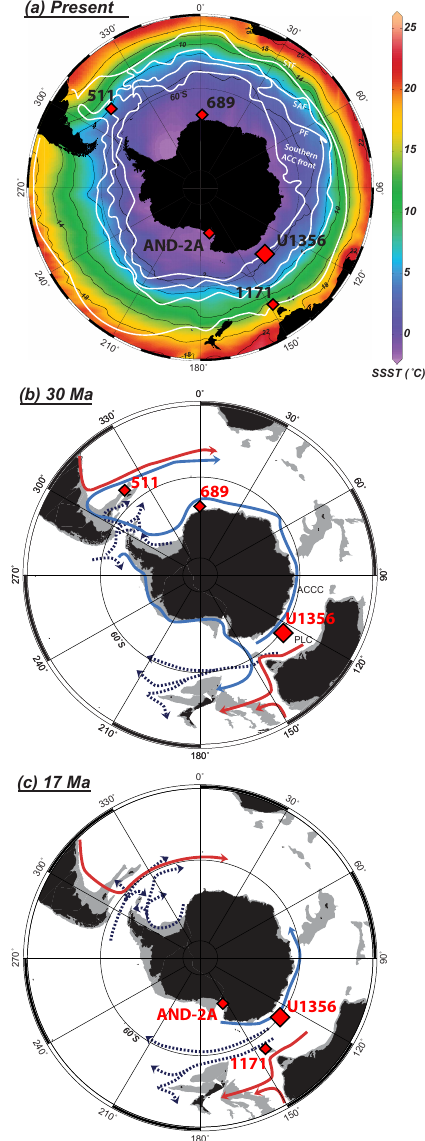
Figure 1. (a) Present-day Southern Ocean summer temperatures and geography obtained from the World Ocean Atlas (Locarnini et al., 2010) using Ocean Data View and Southern Ocean fronts obtained from Orsi et al. (1995). PF: Polar Front; SAF: Sub- Antarctic Front; STF: Subtropical Front. Red diamonds indicate DSDP/ODP/IODP site locations. (b) Map of Antarctica around 30Ma, a modified reconstruction by the Ocean Drilling Strati- graphic Network Plate Tectonic Reconstruction Service (continents in black, shelf areas in grey). Paleo-latitudes calculated with paleo- latitude.org (van Hinsbergen et al., 2015). Reconstructed cold (light blue) and warm (red) surface currents are based on publications by Stickley et al. (2004), Warnaar (2006), Bijl et al. (2011, 2013), and Douglas et al. (2014). Reconstructed bottom-water currents (dot- ted dark blue) are based on publications by Carter et al. (2004), Livermore et al. (2007), Maldonado et al. (2014), and Scher et al. (2015). ACCC: Antarctic Circumpolar Counter Current; PLC: proto-Leeuwin Current. (c) The same as the middle figure, but then for the period around